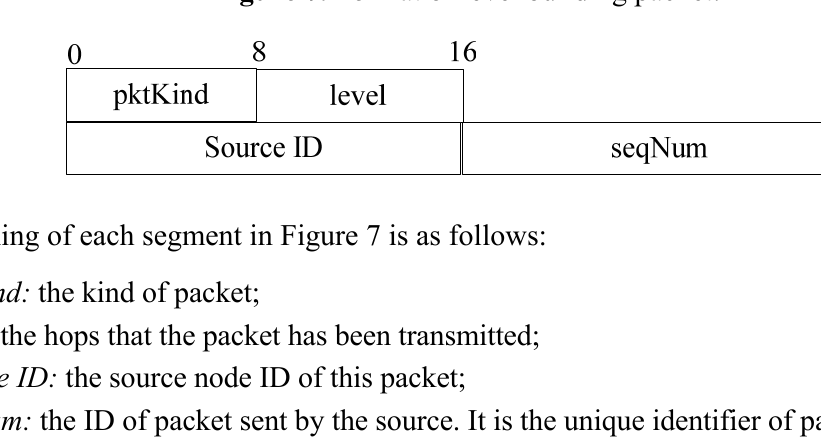
Figure 7. Format of level building packet.